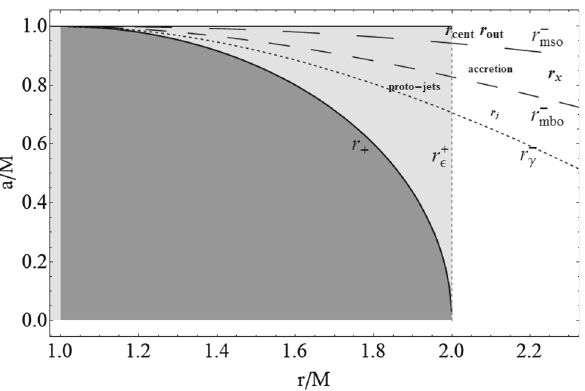
Fig. 16 Theouterergoregion Σ + (cid:10) ≡] r + , 2 M ] (light-grayregion)ofthe Kerr geometry. Gray region is r < r + , r + is the BH horizon. r + (cid:10) = 2 M is the outer ergosurface. Location of inner edge of quiescent tori and tori center, the region of inner edge of accreting tori r × and proto-jets are